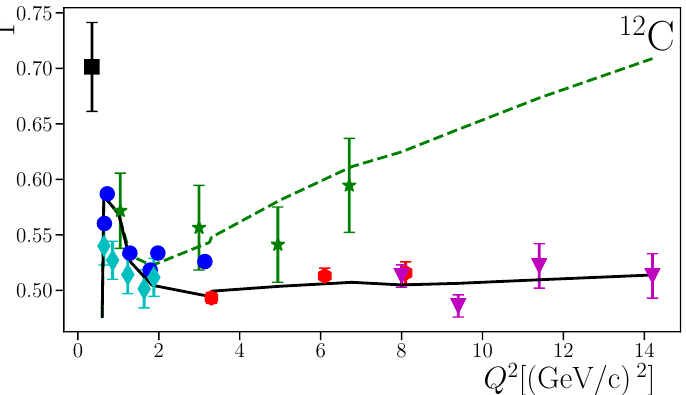
Figure 1. Computed 12 C ( e , e (cid:48) p ) nuclear transparencies versus the 4-momentum transfer squared, Q 2 , in quasielastic kinematics. The solid black line represents the relativistic multiple scatternig Glauber approximation (RMSGA) calculation that excludes color transparency (CT) effects. The dashed green line shows the RMSGA calculation including the CT effects with the prescription of Equation (4). Data are from Refs. [5] (black squares), [6,7] (red hexagons), [8] (green stars), [9] (cyan diamonds), [10,11] (blue circles), and [4] (magenta triangles). Data and calculations do not include the c A = 1.11 correlation factor, often applied in the transparency ratio